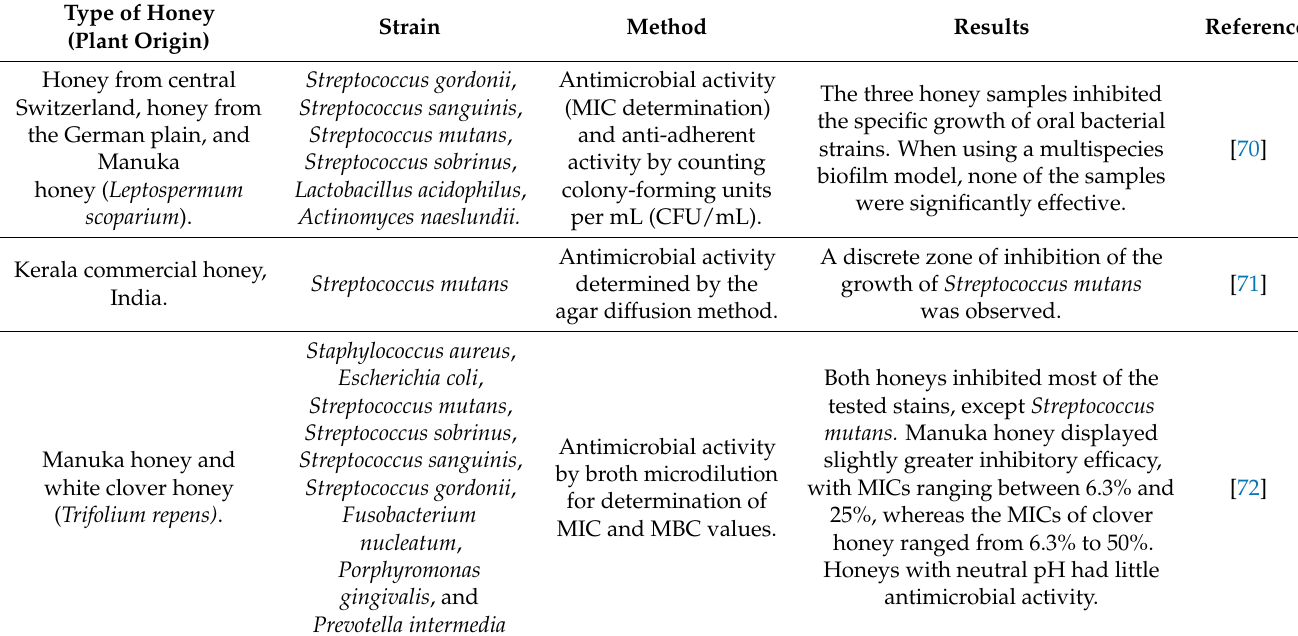
Table 3. In vitro studies of antimicrobial activity of honey against oral